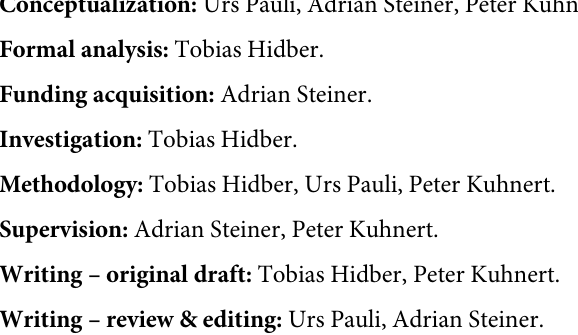
S1 Table. Effectiveness of disinfectants tested in single experiment on growth reduction of D . nodosus